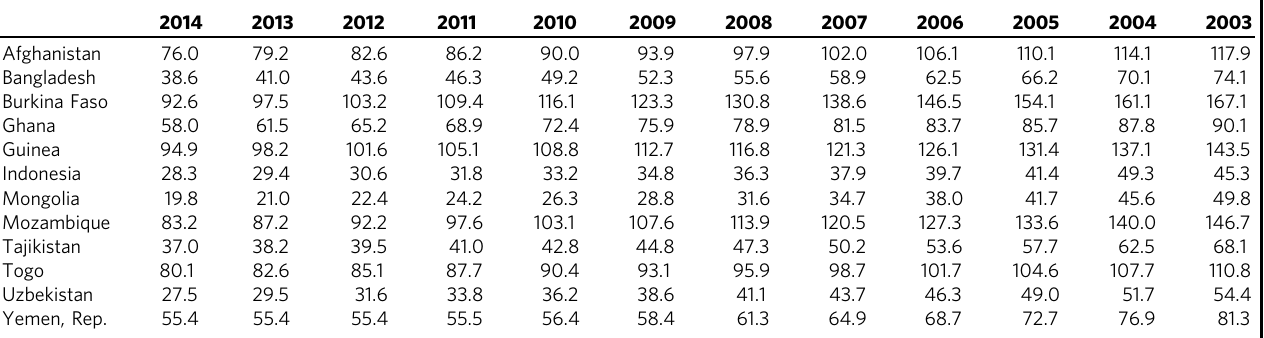
Table 1 U5 Mortality per 1000 live